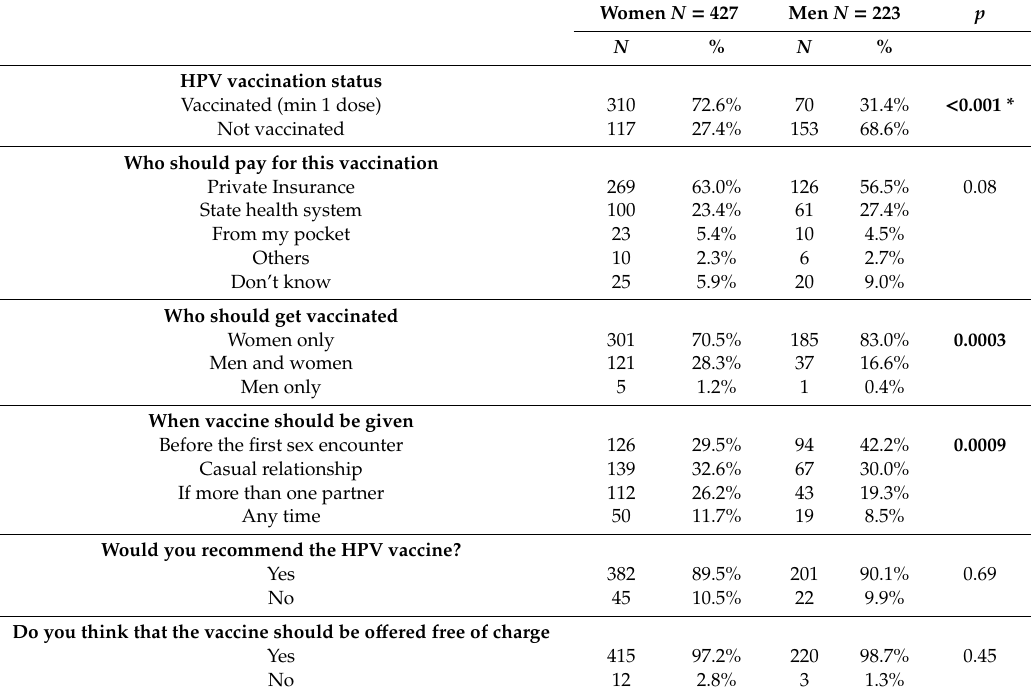
Table 3. Attitudes toward HPV